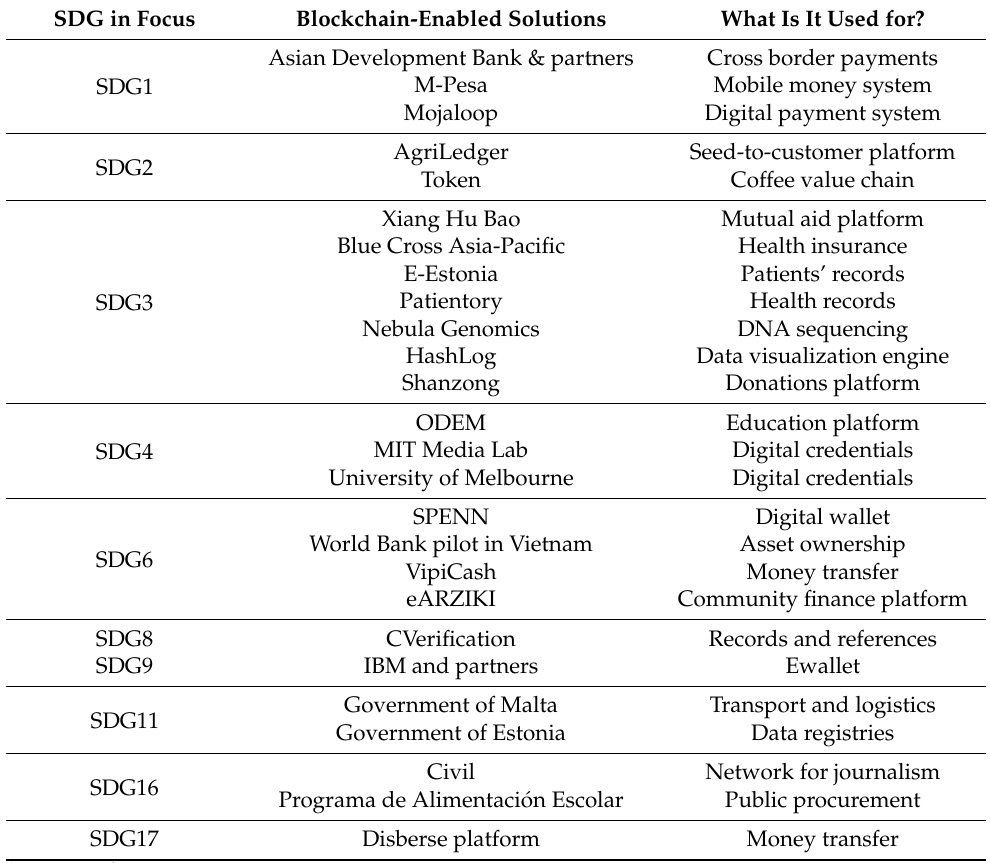
Table 1. Blockchain-enabled solutions according to their SDG focus. SDG in Focus Blockchain-Enabled Solutions What Is It Used